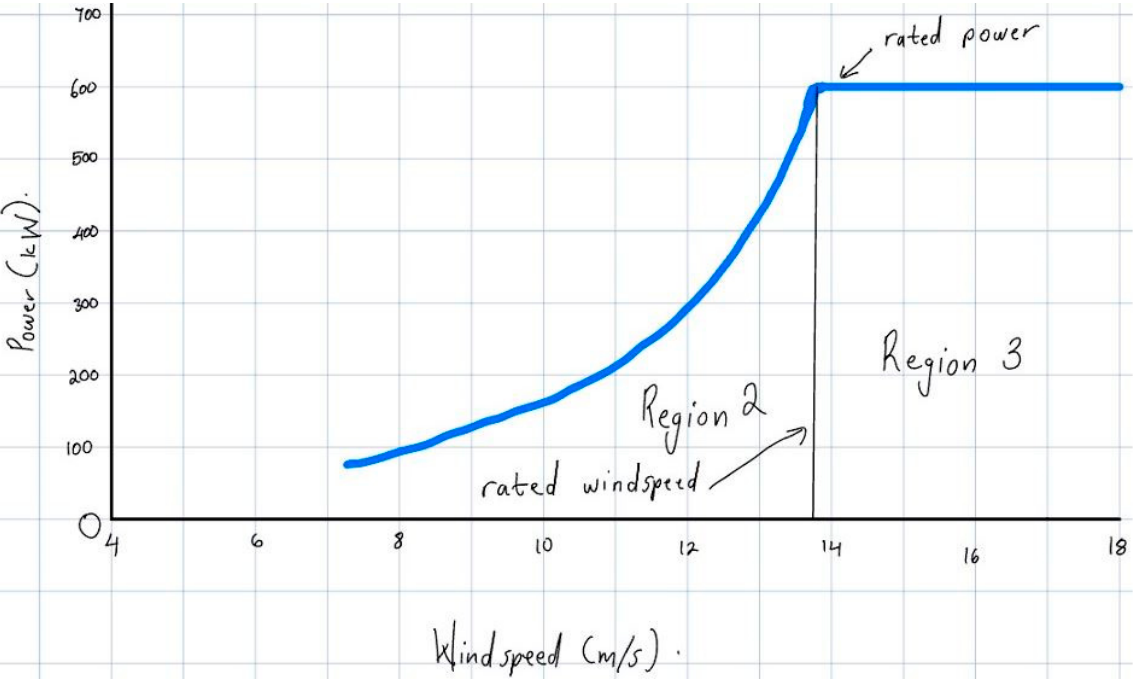
Figure 14. Power vs. wind speed graph showing the different regions of operation [28].